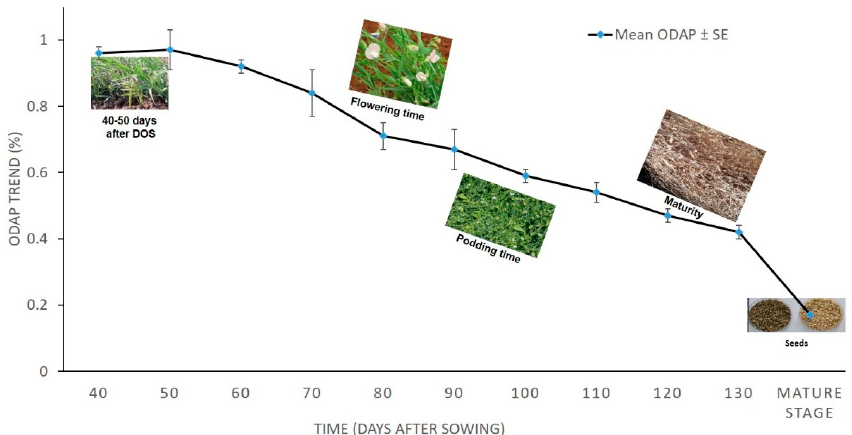
Figure 1. Mean leaf total ODAP content (%) of tested Lathyrus accessions grown during 2010–2011 at Tel Hadya. Y axis presents leaf total ODAP content in percent, X axis denotes Time, Time points were: 1 = 40 DAS, 2 = 50 DAS, 3 = 60 DAS, 4 = 70 DAS, 5 = 80 DAS, 6 = 90 DAS, 7 = 100 DAS, 8 = 110 DAS, 9 = 120 DAS, 10 = 130 DAS, and 11 = mature stage (seeds). Table 3. Mean total ODAP content during different plant development stages in five accessions of grass pea during 2010–11.